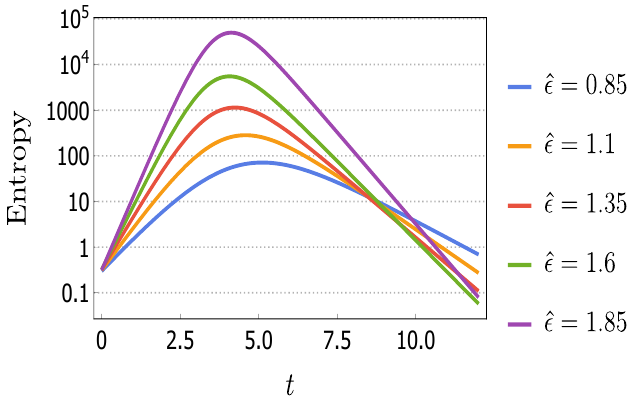
Figure 4 . Evolution of entropy for a K = 2 parameter system with a variation of eigenvalue of Encoder-Dataset tensor A ∞ .